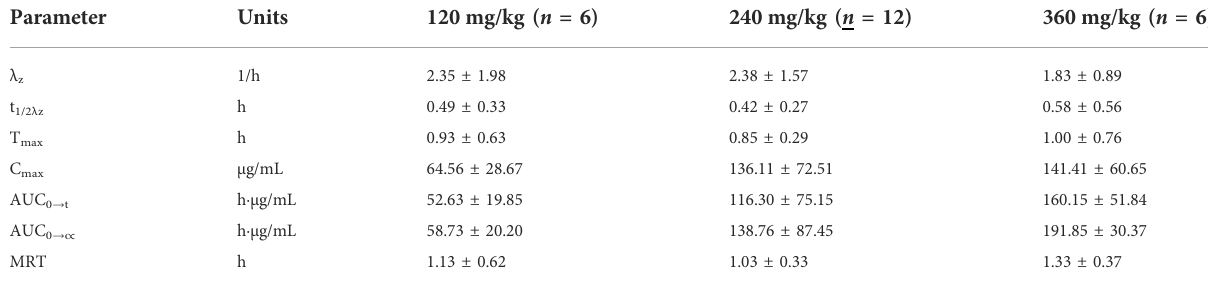
TABLE2MeanpharmacokineticparametersofexogenousGlninBeagle ’ plasmaaftersingleoraladministrationofthreedifferentdosesofGlntablets. (mean ± SD). Parameter